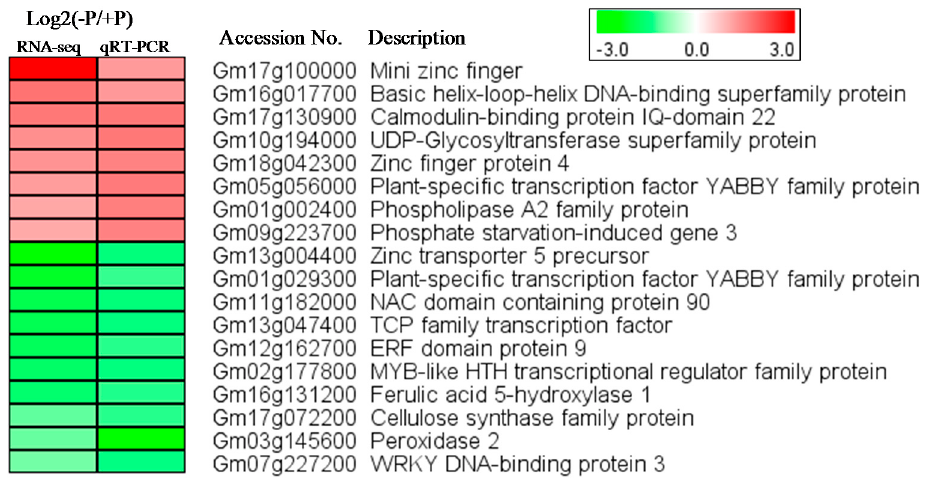
Figure 2. Heatmap of the expression of 18 randomly selected differentially expressed genes (DEGs) as revealed by RNA-seq and qRT-PCR. The intensities of the color represent the fold changes in log2 values according to RNA-seq data or qRT-PCR results. Red color indicates induction and green color indicates repression. Accession number “Glyma.” is named as “Gm” for short. − P refers to PDL and +P refers to PSL.